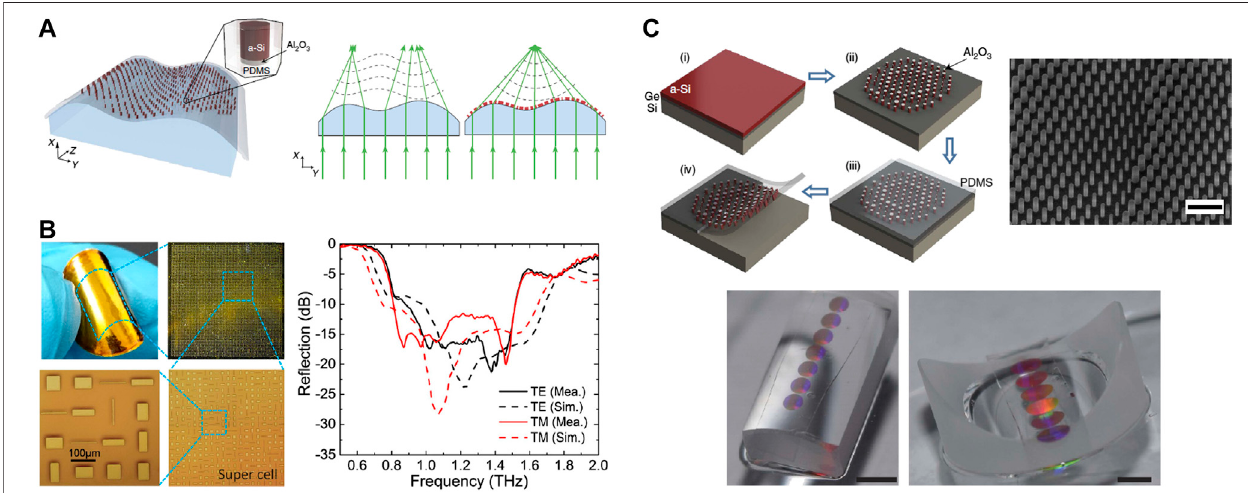
FIGURE 6 | (A) Soft metasurface conformed to the surface of a transparent object with arbitrary geometry to re-shape the wavefront and realize the focusing of transmissive electromagnetic wave [66]. (B) Microscopic pictures of the soft metasurface and its re fl ection spectrum of transverse electric (TE) and transverse magnetic (TM) modes of the electromagnetic waves within THz frequency domain [185]. (C) Process of developing the soft metasurface via transfer printing [66]. Figure reproduced with permission from: (A) – (C) , © 2016, Nature Publishing Group